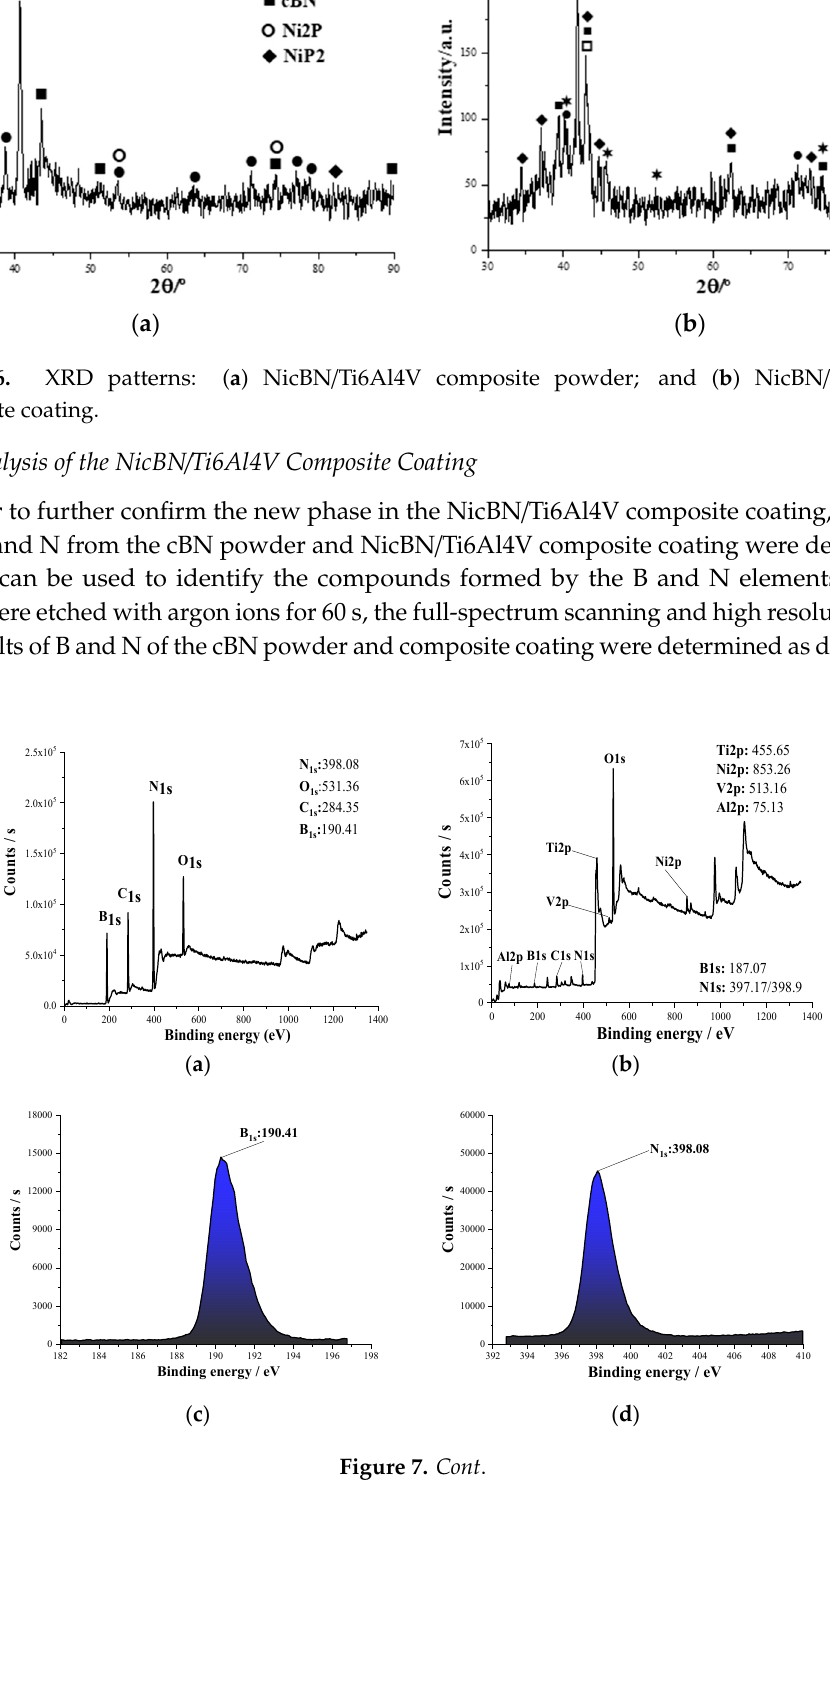
( b ) Figure 5. Images of SEM and EDS: ( a ) SEM image at the interface of a cBN particle; ( b ) element mapping of a cBN particle in the composite coating. Table 2. Elemental concentration of the selected areas of the cBN/Ti6Al4V interface. Elements(wt.%)